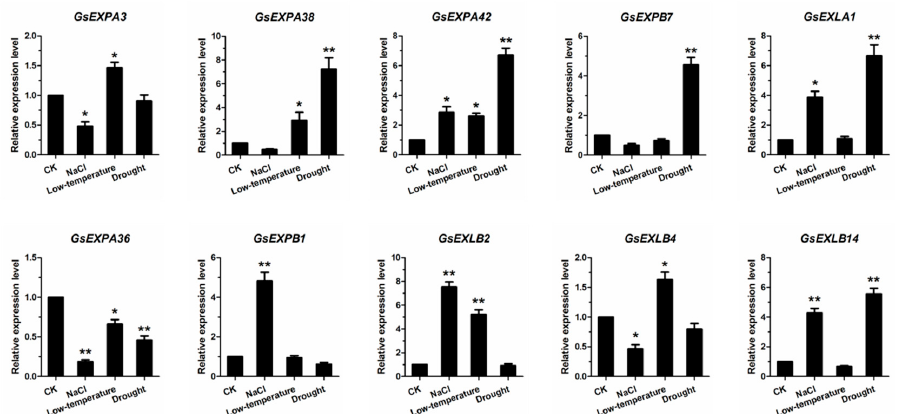
Figure 8. qRT-PCR detection of candidate 10 wild soybean expansin genes response to salt, low temperature and drought stress. * indicates that the transcription level of the expansin gene is significantly different from that of control group (*, p < 0.05; **, p < 0.01).